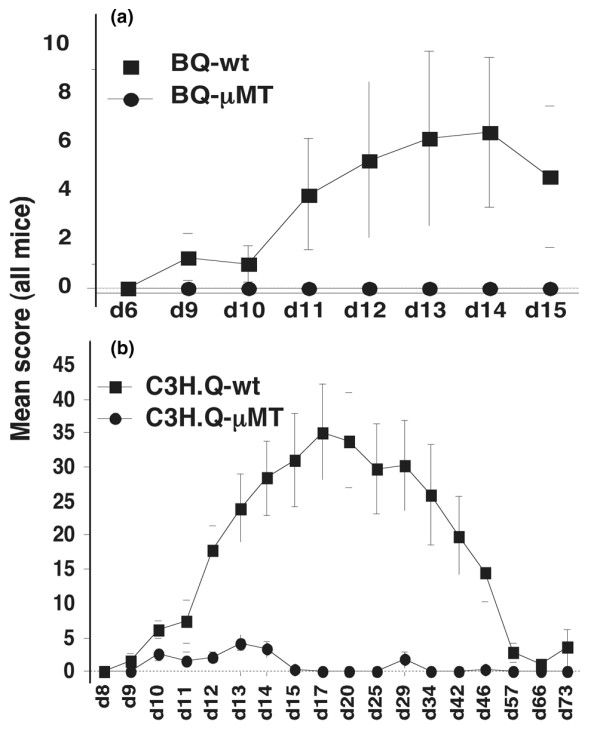
Role of B cells in the pathology of G6PI-induced arthritis. The role of B cells in the pathology of glucose-6-phosphate isomerase (G6PI)-induced arthritis was addressed using B-cell deficient μMT mice on B10.Q and C3H.Q backgrounds. Mice aged between 6 and 7 weeks were immunized with 200 μg G6PI in complete Freund's adjuvant and scored for arthritis. (a) Five out of seven B10.Q mice developed arthritis, whereas none of the six B10.Q μMT mice exhibited signs of inflammation. (b) Four out of 12 C3H.Q μMT mice exhibited mild oedema for no longer than 48 hours, whereas all nine C3H.Q littermate control mice demonstrated a destructive inflammatory disease course. Error bars indicate the standard error of the mean.